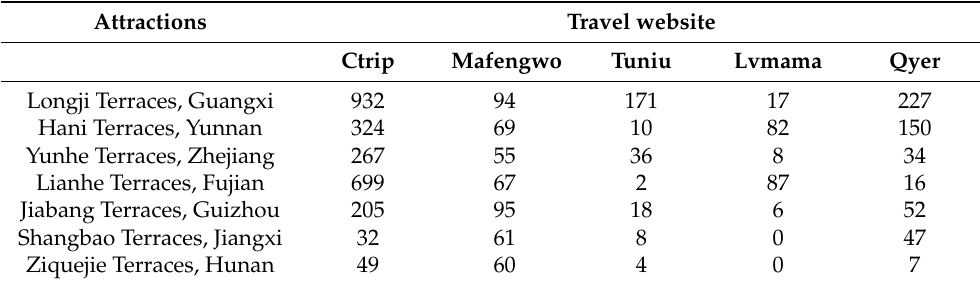
Table 1. Distribution of travel notes collected from tourism websites.